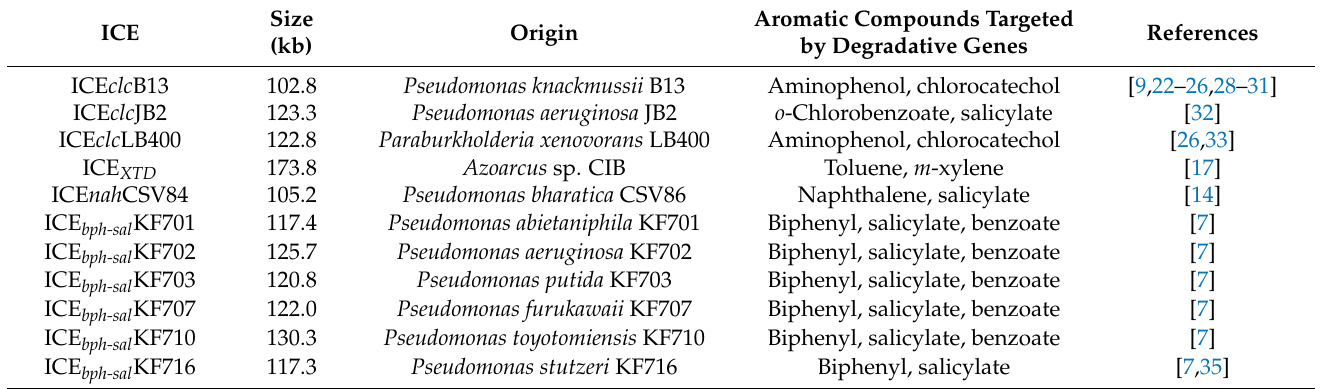
Table 1. ICE clc family